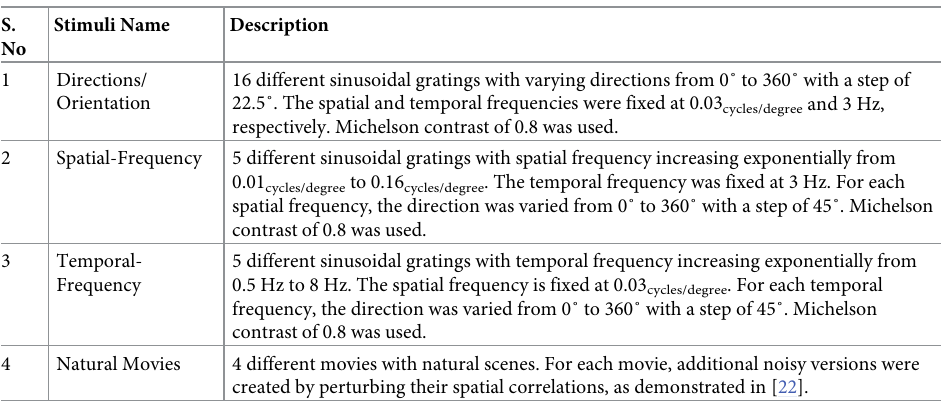
Table 1. Summary of different stimuli shown to